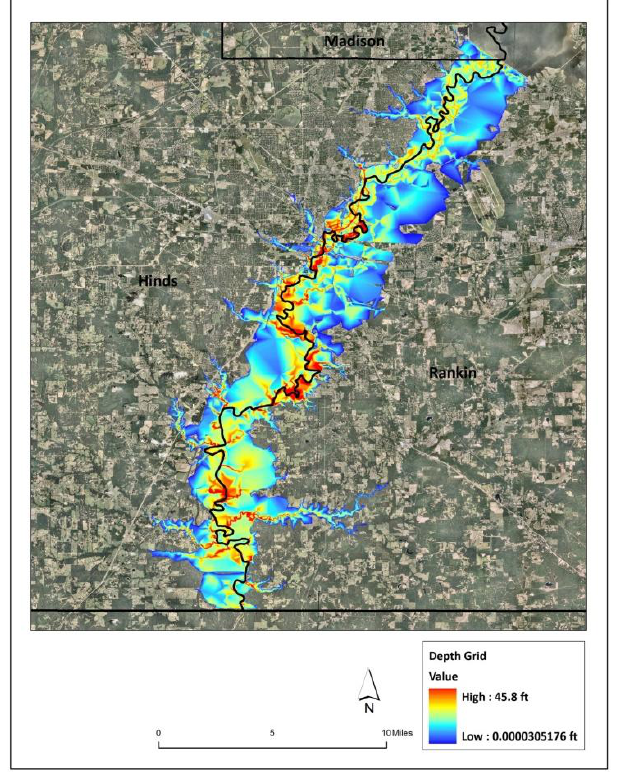
Figure 13. Depth grid of inundation downstream of Ross Barnett